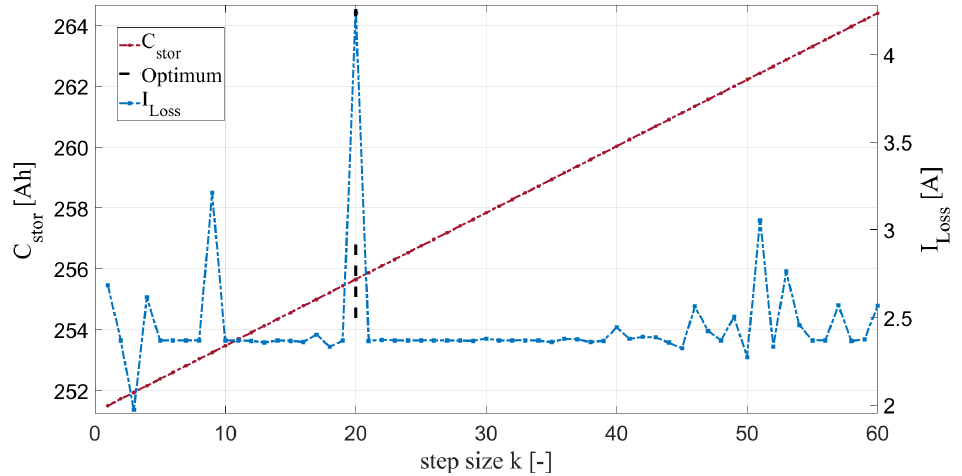
Figure 7. Third optimization step of C Stor and I Loss with preset step size of k = 60